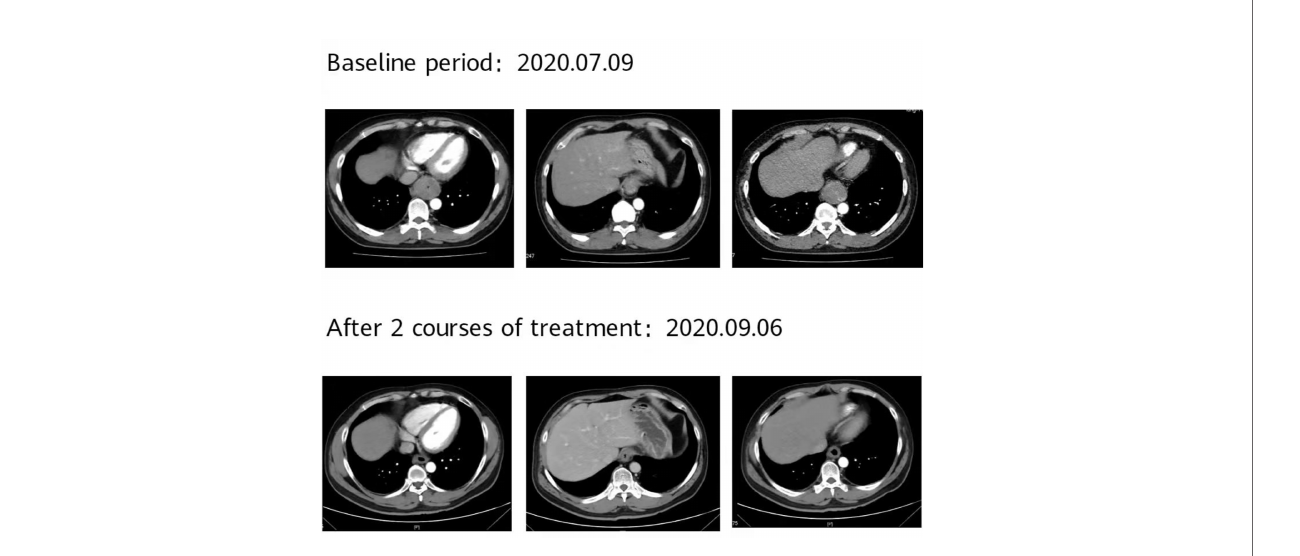
FIGURE 7 | The patient ’ s imaging examination ef fi cacy evaluation was based on the Response Evaluation Criteria in Solid Tumours 1.1. After 2 courses of treatment, re-examination of the second-phase enhanced CT of the lungs showed that the esophageal lesions were reduced compared with the baseline, and the curative effect was evaluated as partial remission